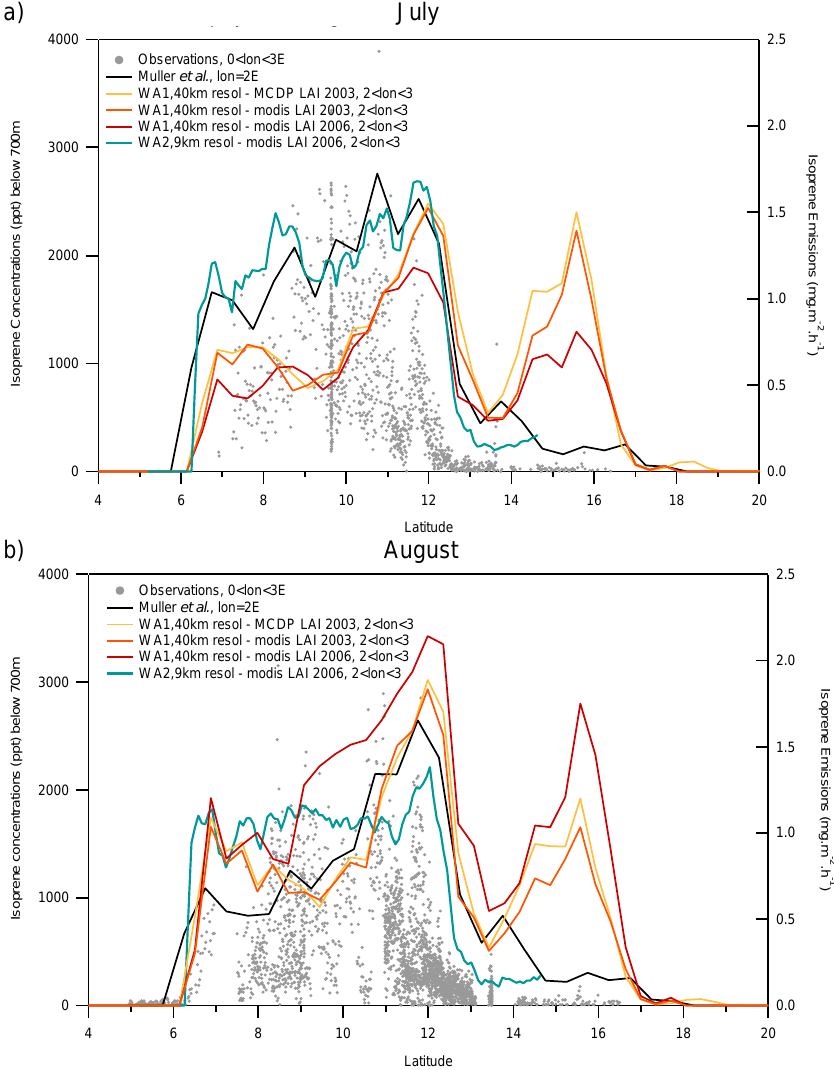
Fig. 8. Latitudinal variation of isoprene emissions for WA1 (based on the three sources of LAI data and on results obtained by Muller et al., 2007) and for WA2 (LAI MODIS 2006), and observed concentrations in (a) July and (b) August 2006.